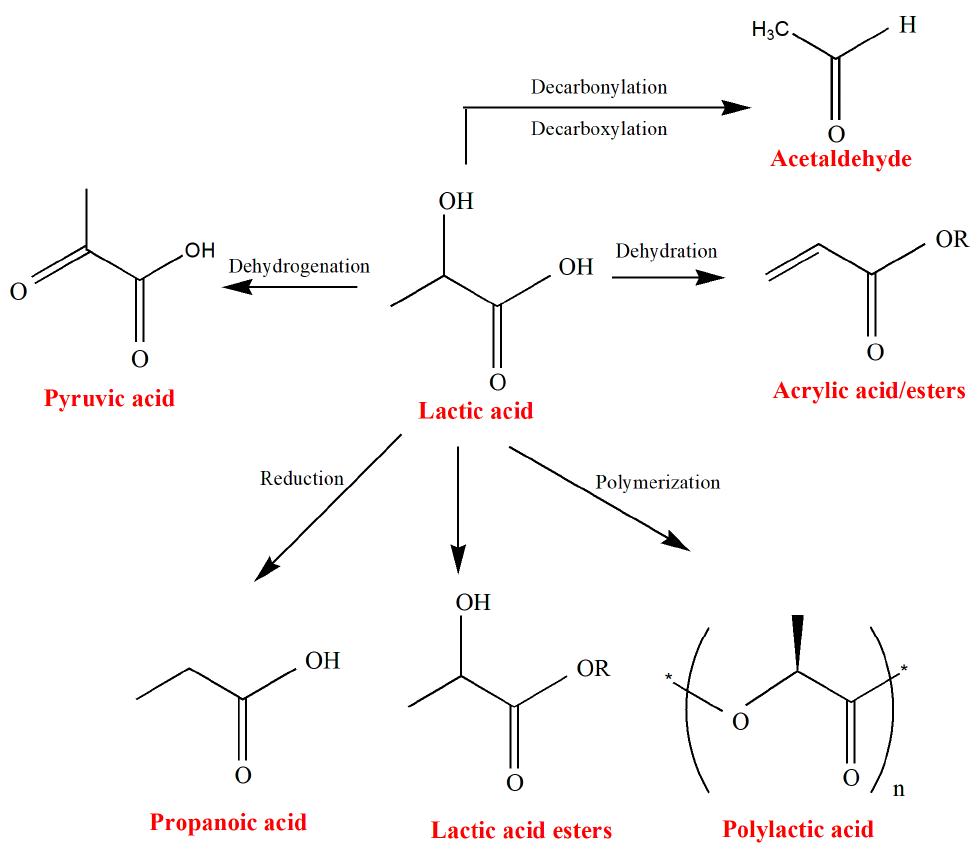
Figure 13. Conversion of lactic acid to chemicals (Redraw from ref. [15]).